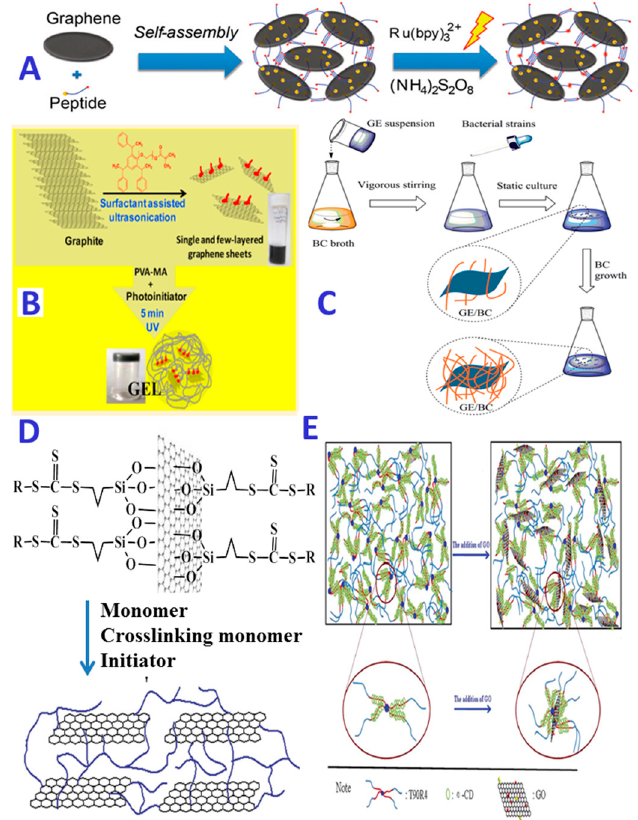
Figure 5. Schematic illustrations of incorporating graphene-based materials into hydrogel matrixes; The formation of graphene-hydrogel composite materials by ( A ): self-assembly and photo-crosslinking between graphene and peptide, reproduced with permission from